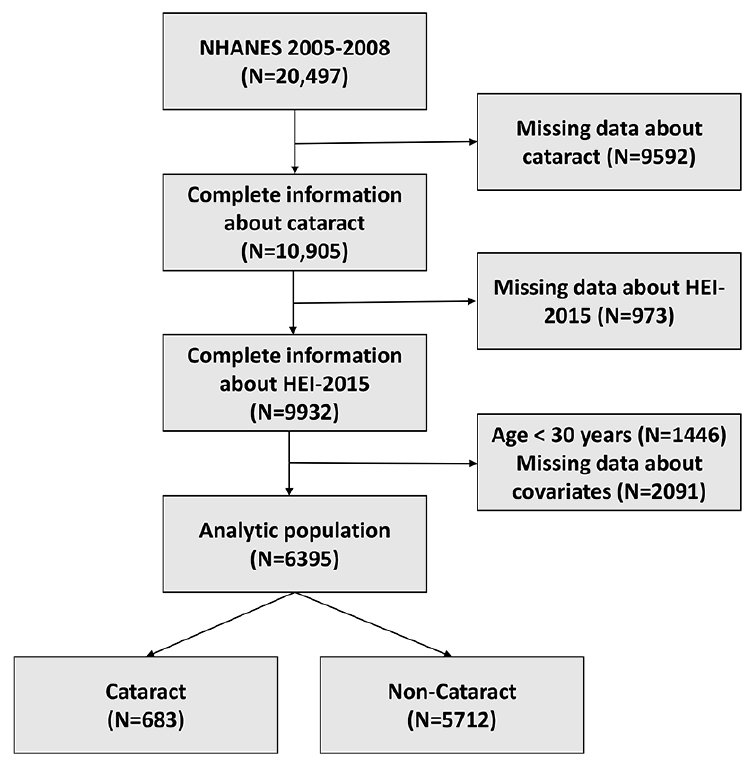
Figure 1. Flow chart of the study population.